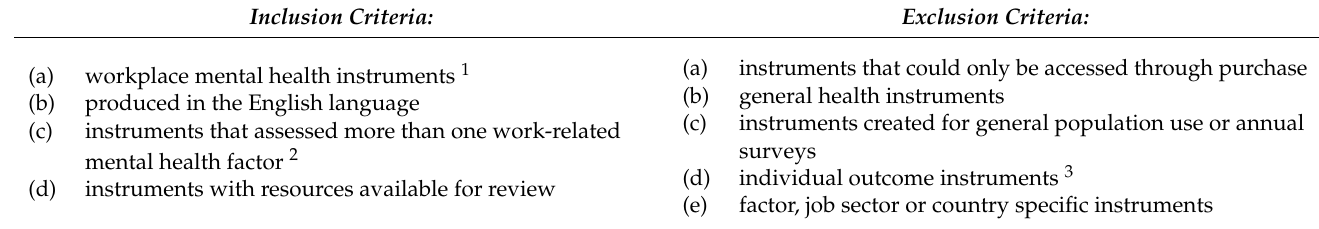
Table 1. Eligibility criteria.